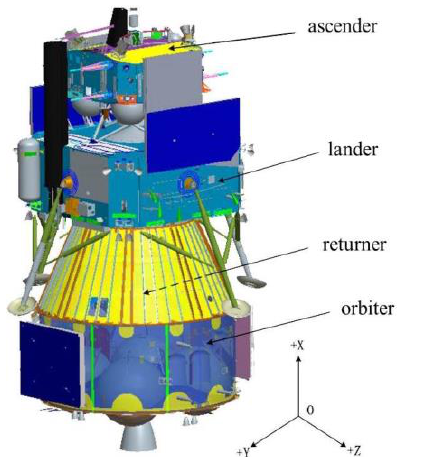
Figure 1. Emission configuration of Chang'E-5 detector